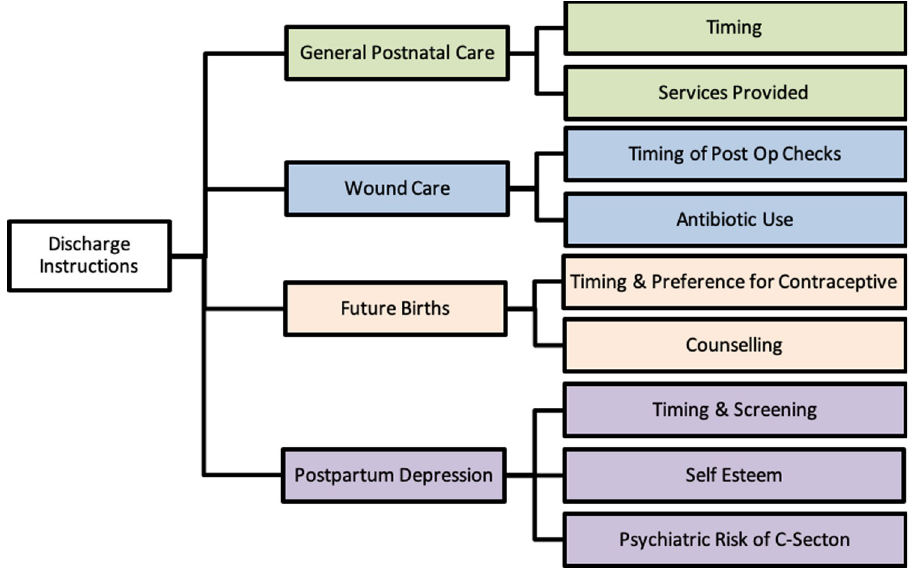
Fig 2. Thematic groups of data analysis.